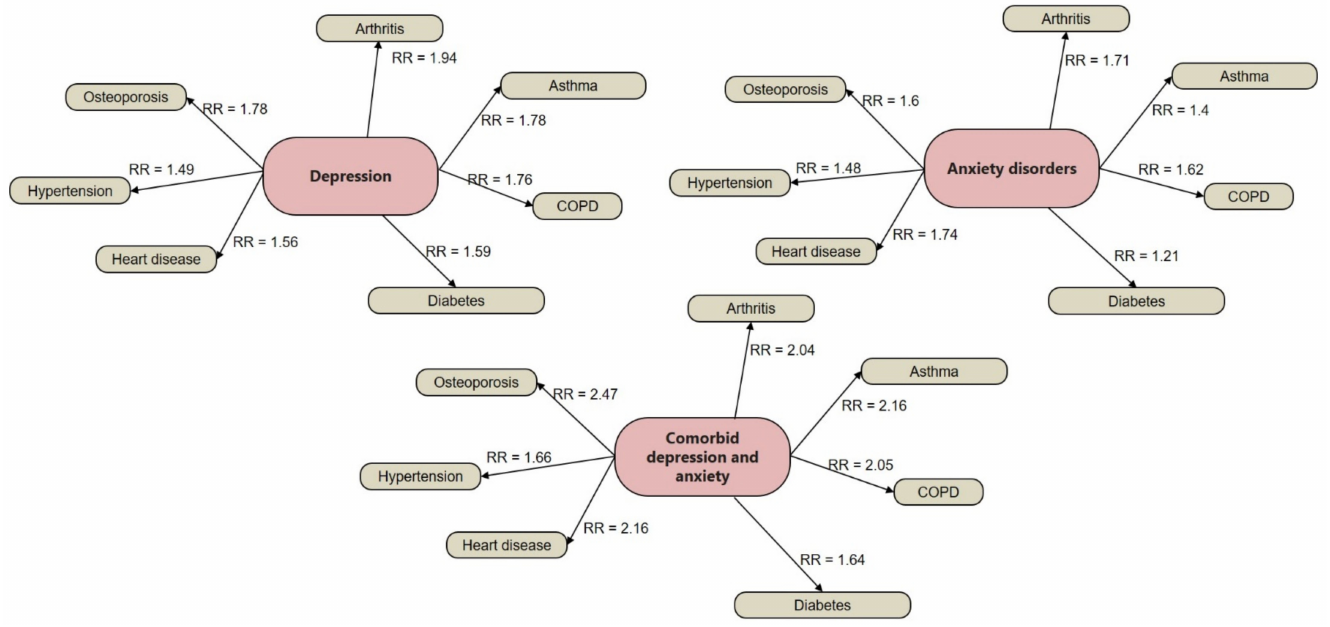
Figure 2. Associations between depression, anxiety, and comorbid depression–anxiety and chronic physical condition risk ratios (RR). Analytic sample comprised of 33,242 adults (51% women) with ages between 22 and 64 years, with no self-reported diagnosis of schizophrenia, psychoses, attention deficit hyper activity disorders, adjustment disorders, substance abuse disorders, and personality disorders. COPD = Chronic Obstructive Pulmonary Disease. Individuals were part of the Medical Expenditure Panel Survey annual releases of 2007 and 2009 in the United States. Data were published in [26]. Reprinted/adapted with permission from ref. [19]. 2022, Diana M.